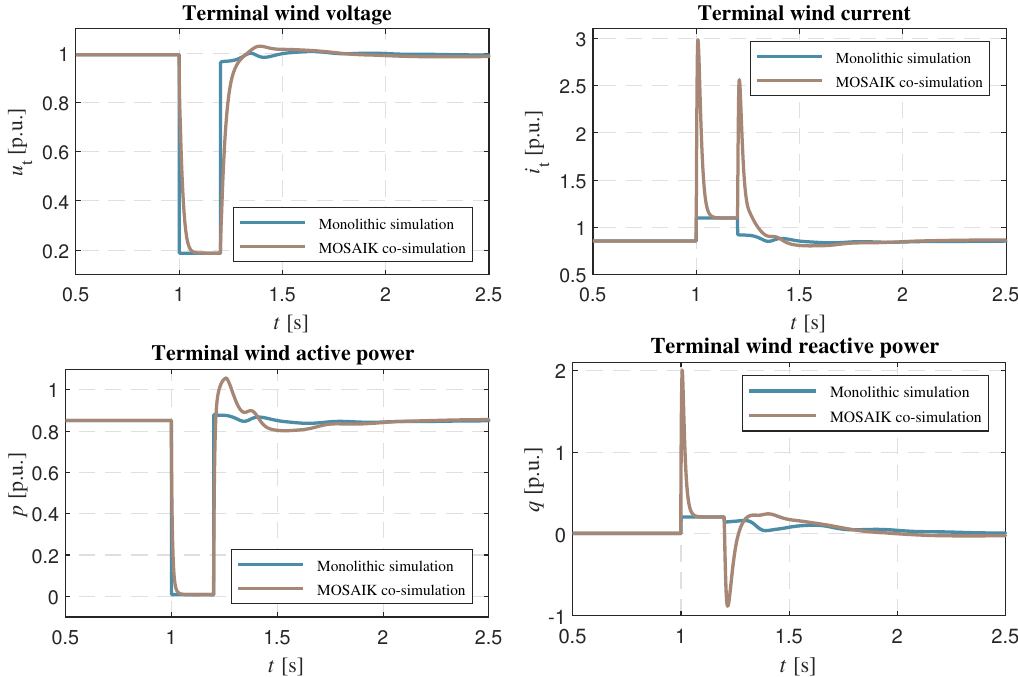
Figure 17. Dynamic response of the wind turbine to the fault with FCT =